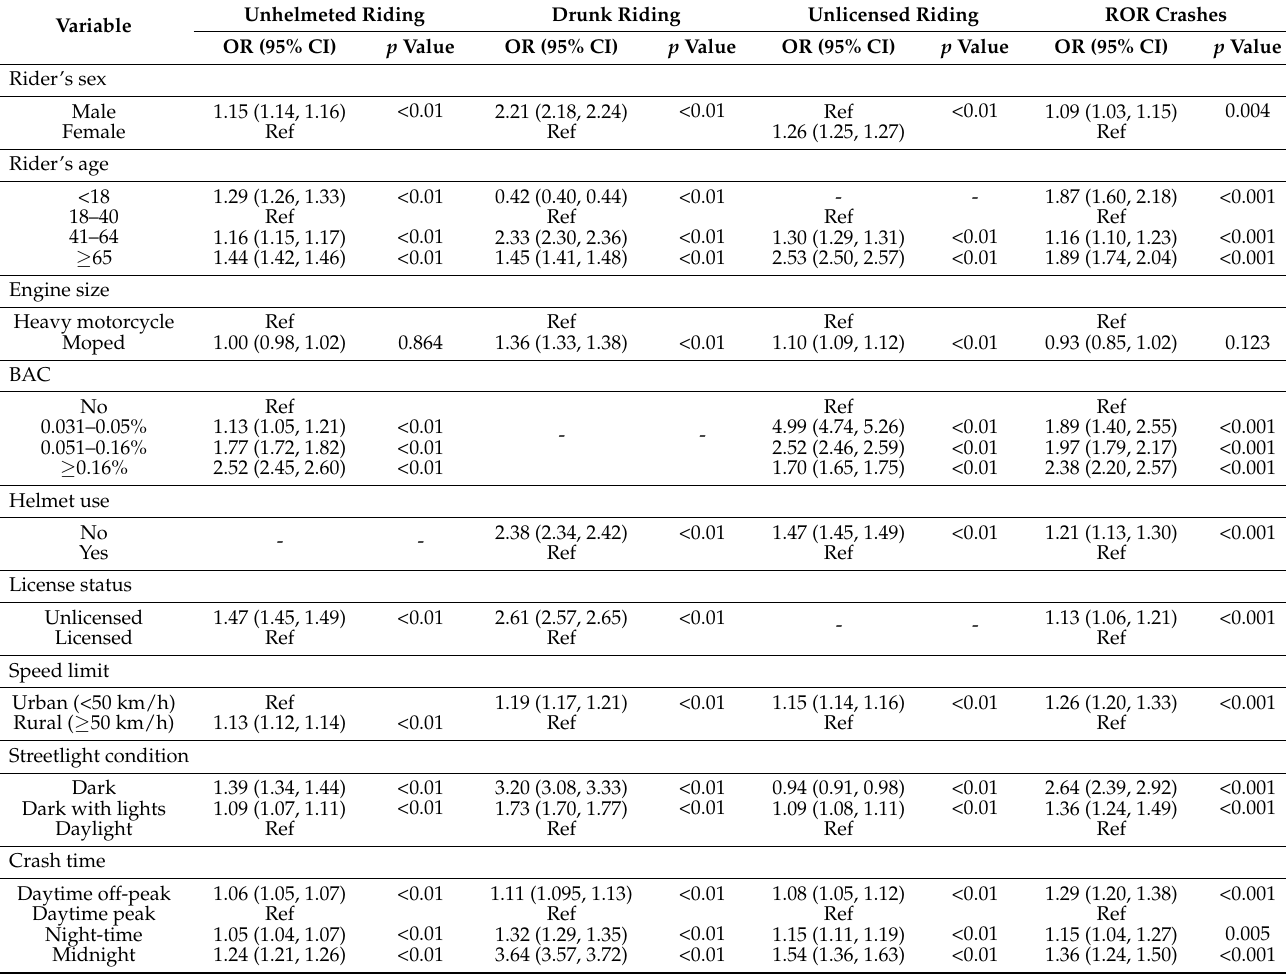
Table 4. Multivariate logistic regression